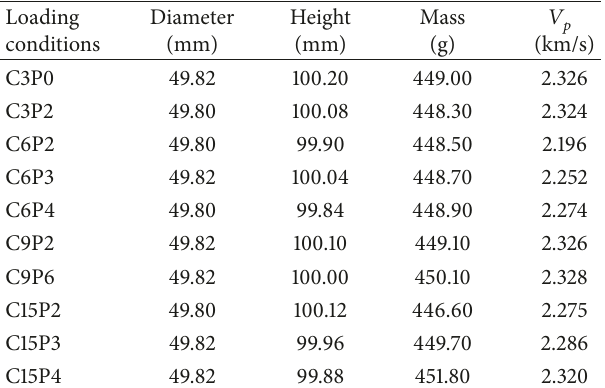
Table 1: Loading conditions and parameters of sandstones without mud.